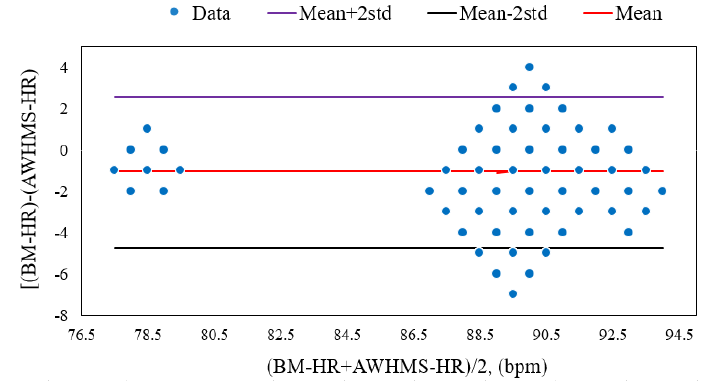
Figure 12. Bland–Altman plot of HR measurement.